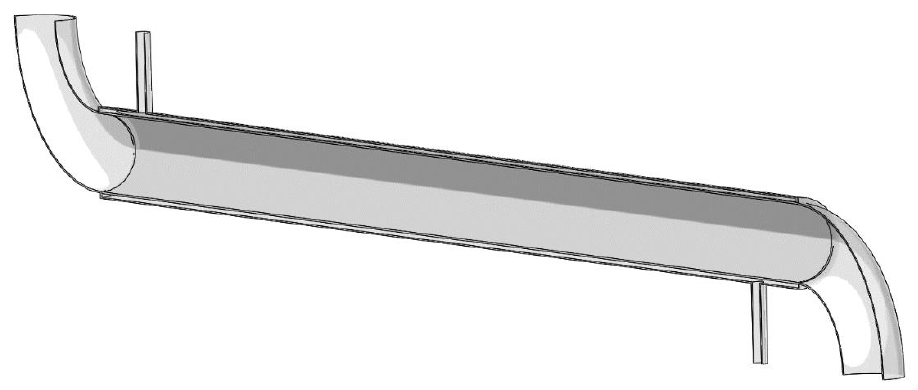
Figure 1. Three-dimensional model—longitudinal